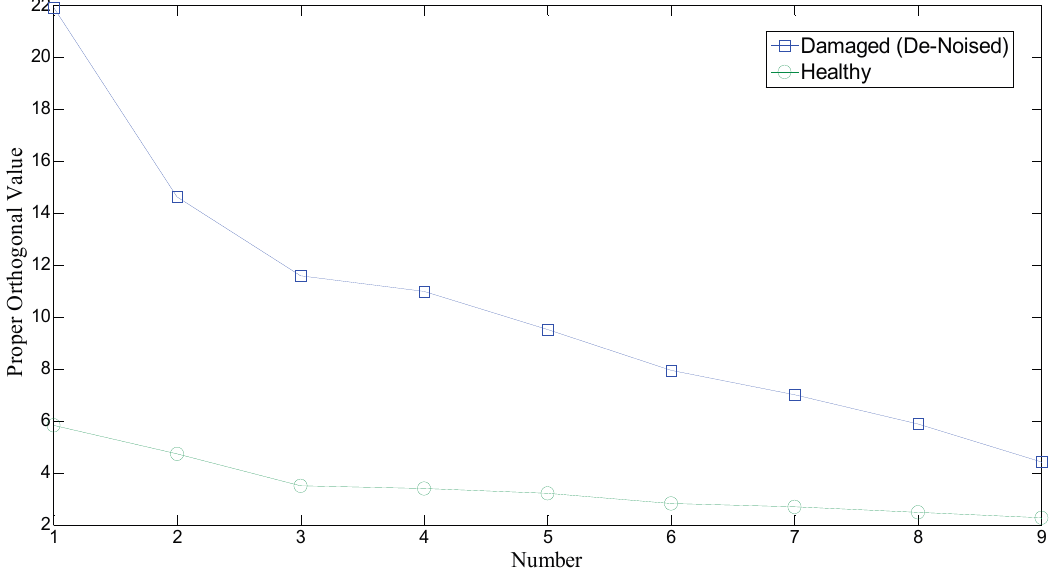
Figure 11. Proper orthogonal values of the collected covariance matrix of the IMFs from segments.